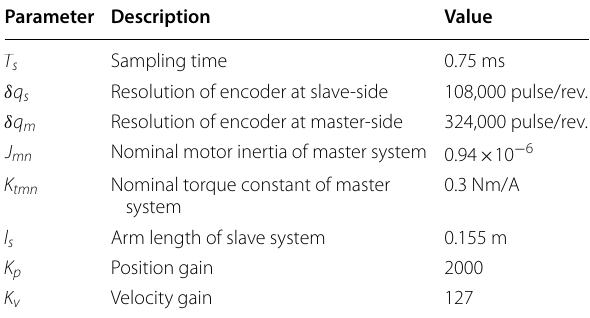
Table 2 Parameters used in the